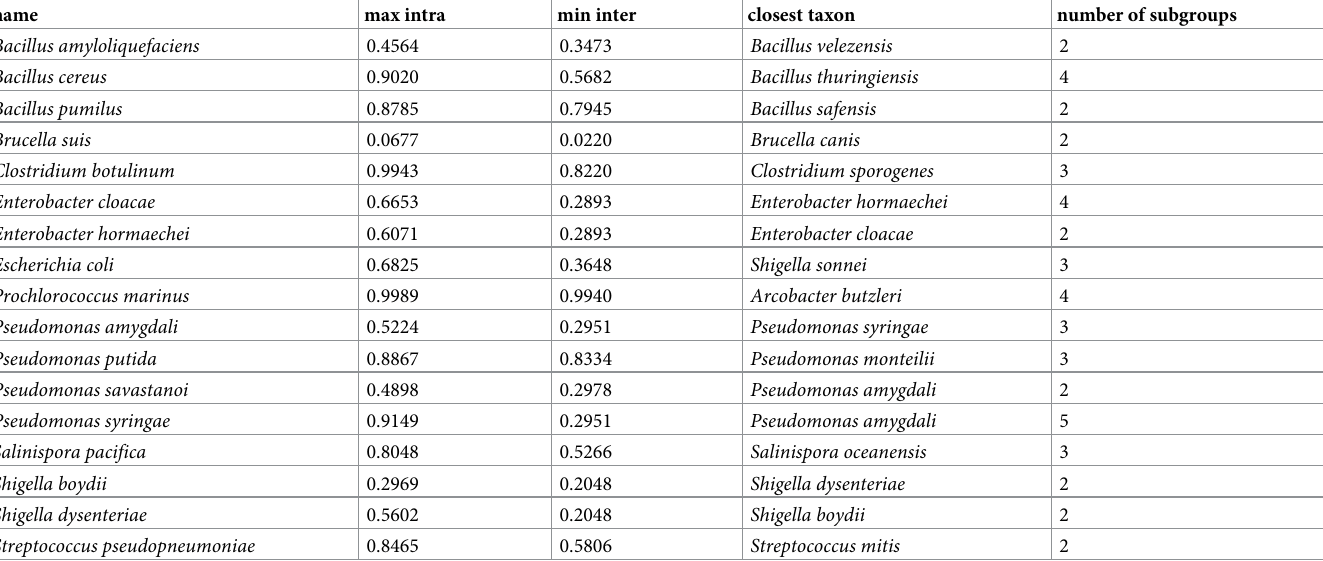
Table 2. Species in the GAMBIT database that were broken into subspecies during the process of establishing